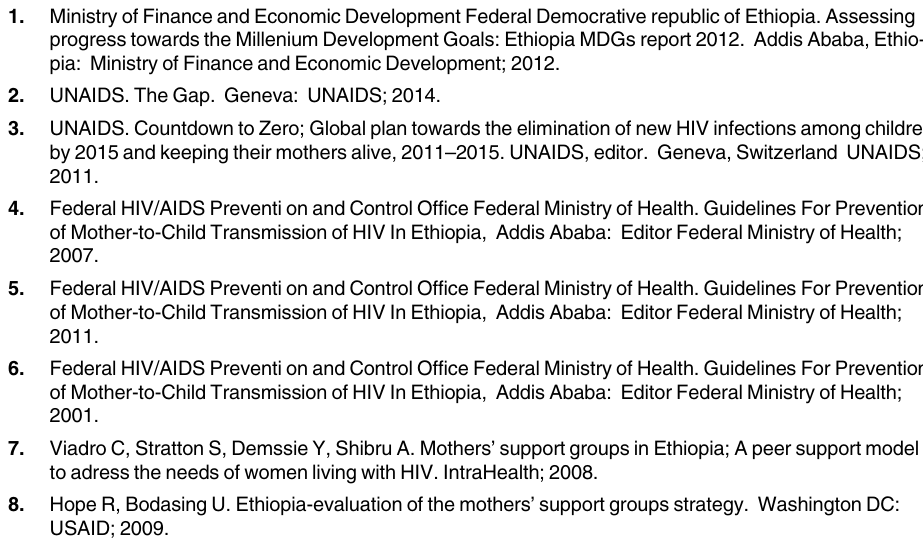
antibody HIV test. Results by 18 months of age and babies with missing data on rapid antibody test results by 18 months of age. Table C: Number and percentage of women whose partner HIV testing status were